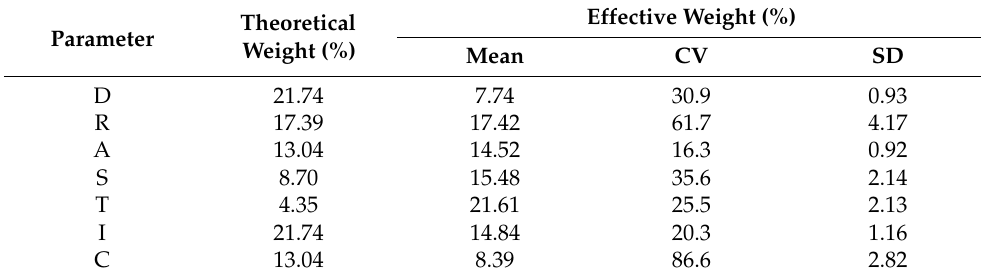
Table 6. Theoretical weights and effective weights after single-parameter sensitivity